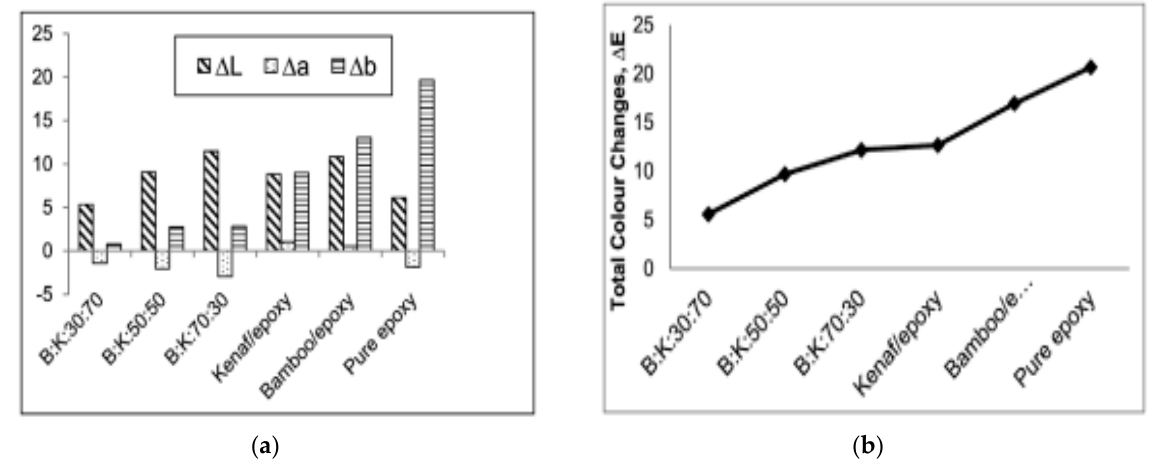
Figure 17. ( a ) Change in brightness (∆𝐿) and chromatic coordinates ( ∆𝑎 , and ∆𝑏 ), ( b ) total change in color after the samples have been exposed to weathering process [192] (Reprinted/adapted with permission from Elsevier Ref.5457250582417 Copyright 2019).